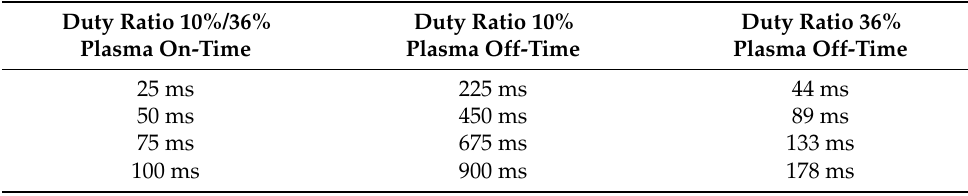
Table 1. The plasma on/off time when the duty ratio was fixed at 10% and 36%.